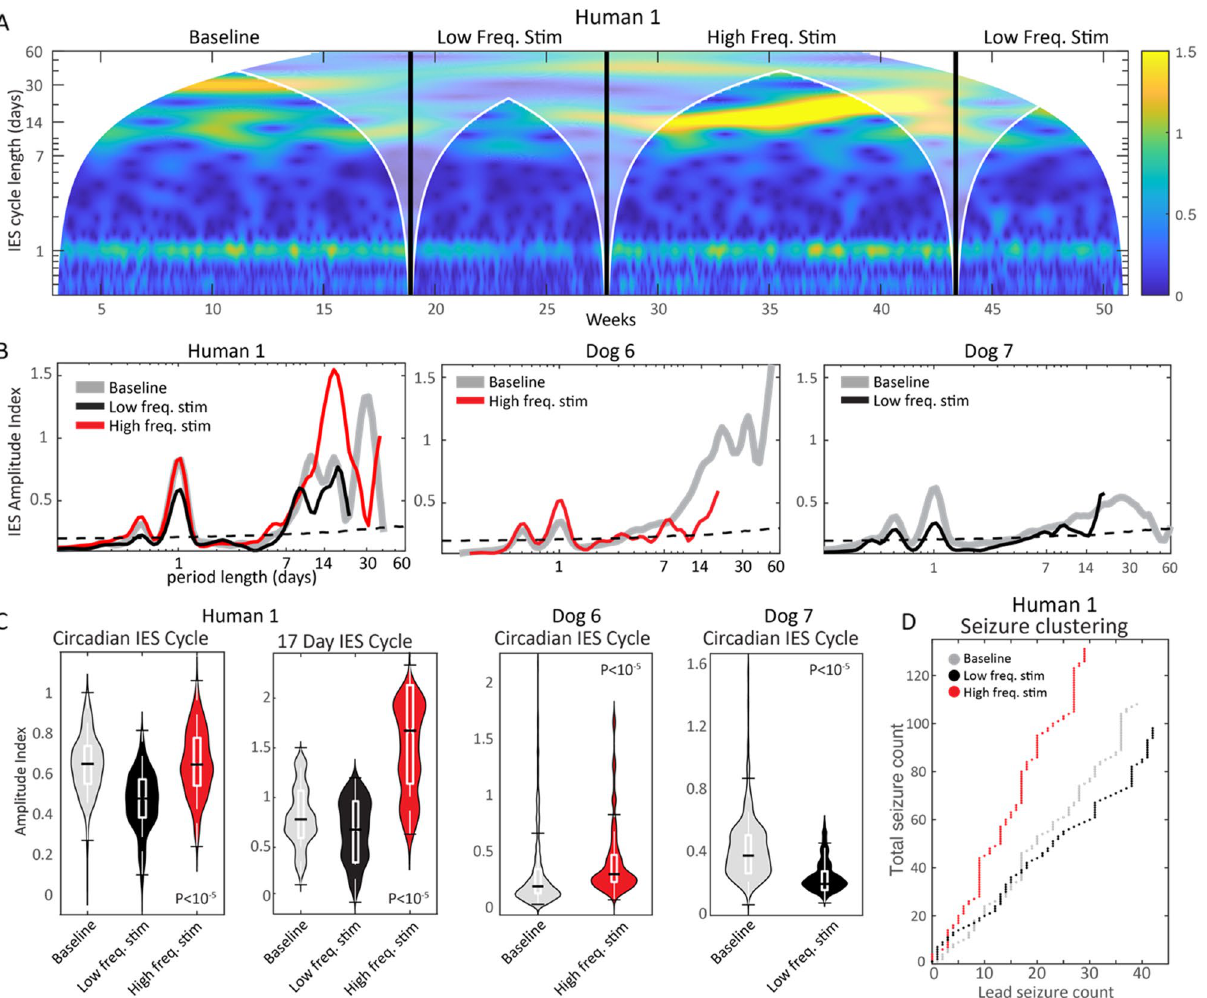
Figure 5. Thalamic DBS modulates IES and seizure cycles in epilepsy. ( A ) Spectrogram of hourly average IES rate during DBS-off baseline, low frequency DBS, and high frequency DBS. ( B ) Amplitude spectral density of IES rate for pet dogs D6 and D7 and human subject H1. H1 shows frequency specific modulation of the ultradian, circadian and multiday IES rhythms. Similarly, DBS in canines modulated the amplitude of ultradian and circadian rhythms. The impact on multiday canine rhythms was unclear because of inadequate sampling. ( C ) Violin plots of circadian and multiday spike rate cycle amplitude in human and pet canines. ( D ) Thalamic DBS also modulates seizure clustering with low frequency ANT DBS reducing overall seizure counts. ANT anterior nucleus of thalamus, D6 and D7 dog 6 and 7, DBS deep brain stimulation, IES Interictal epileptiform